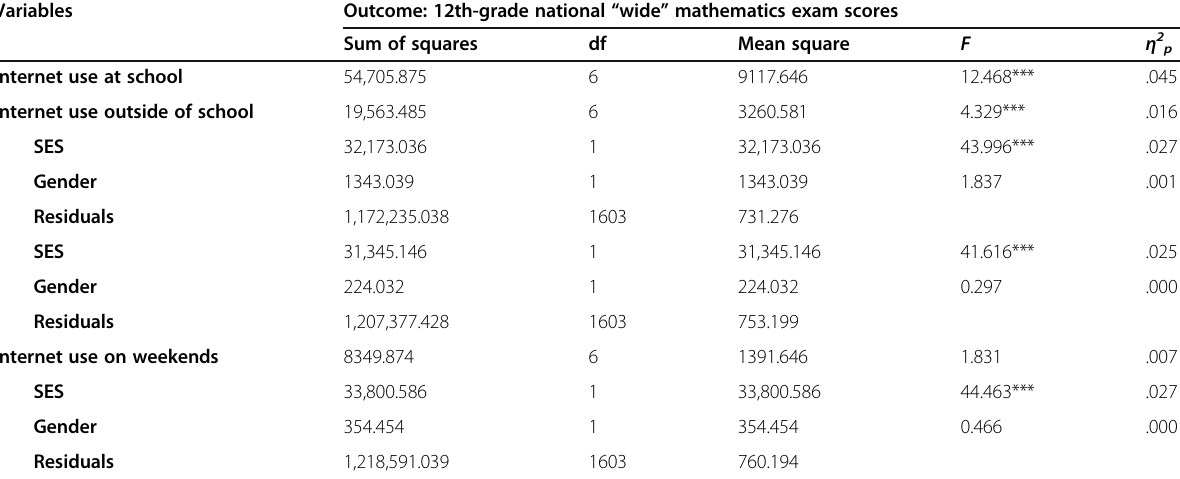
Table 4 Results of ANCOVA analyses for 12th-grade “ wide ” mathematics national exam scores and Internet use variables, controlled for SES and gender